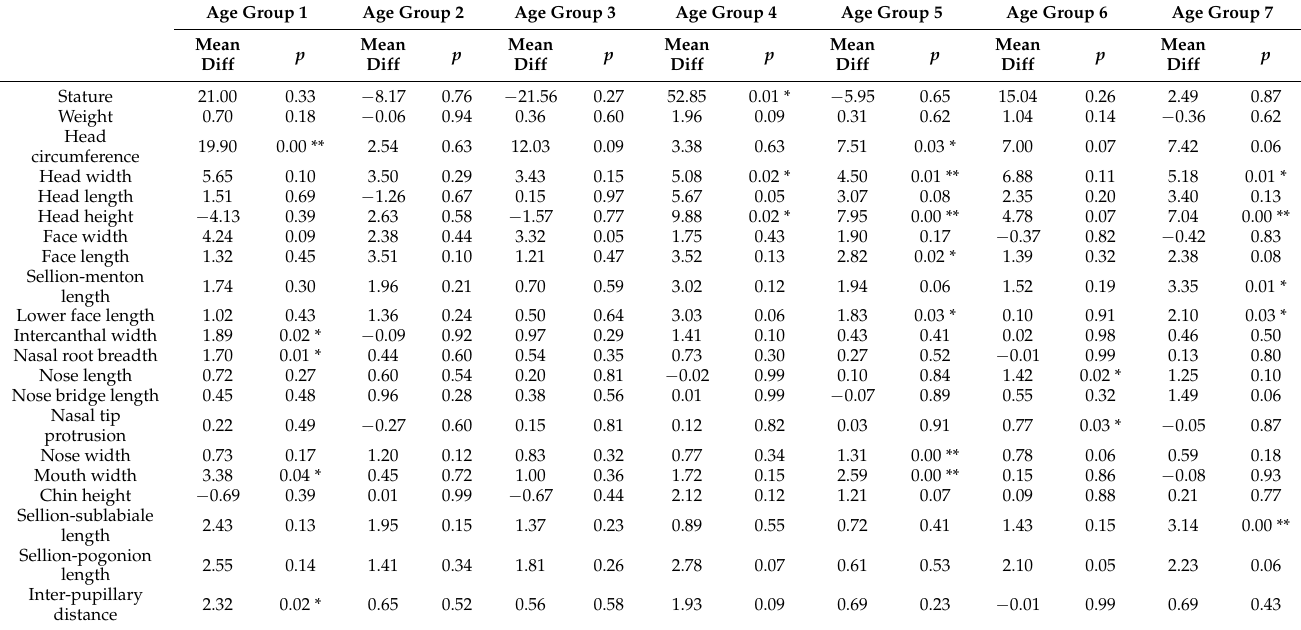
Table 3. Independent t -test between boys and girls for each age group (mean difference in